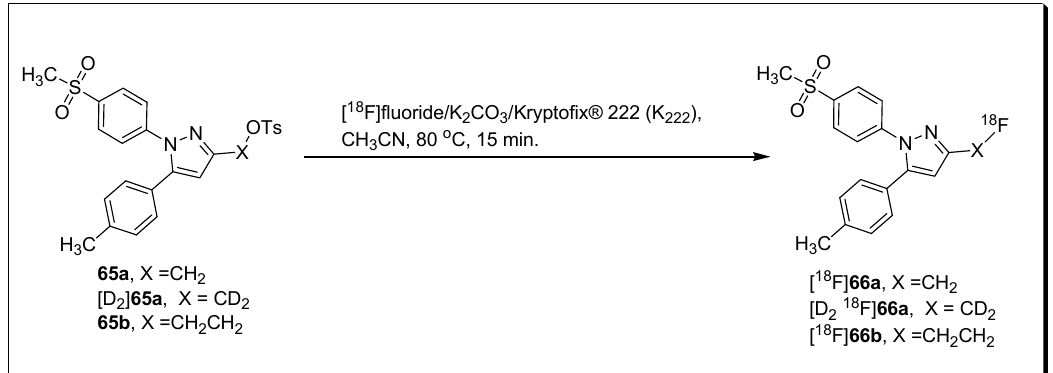
Figure 22. Radiosynthesis of [ 18 F] 66a,b and [D 2 , 18 F] 66a . 11. 2021